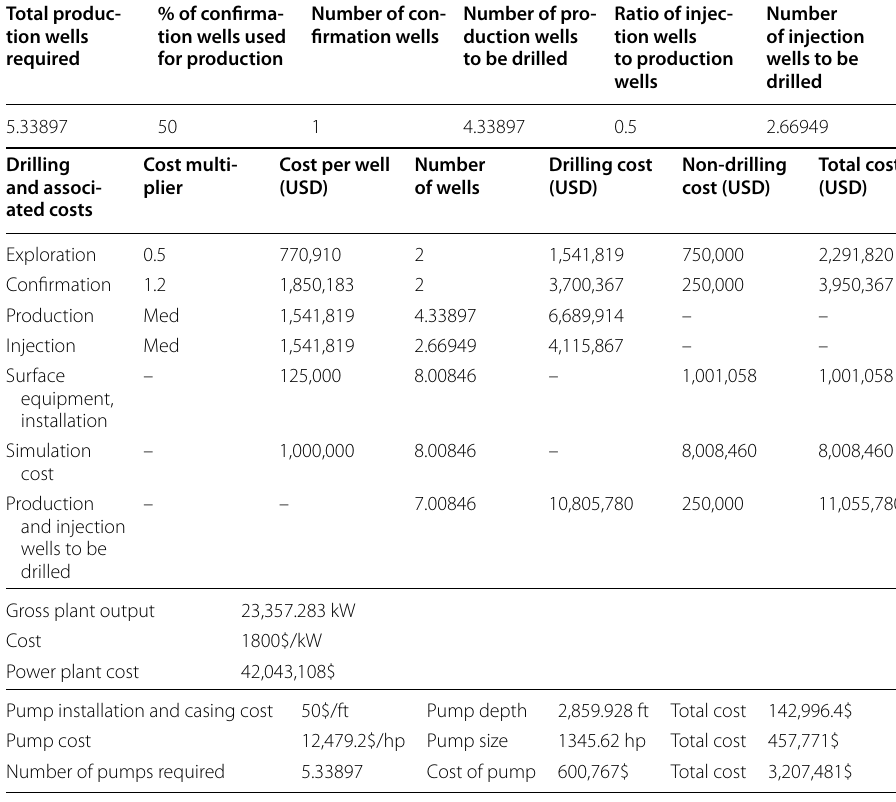
Table 3 Configuration specification dialog for the geothermal well Total produc- tion wells